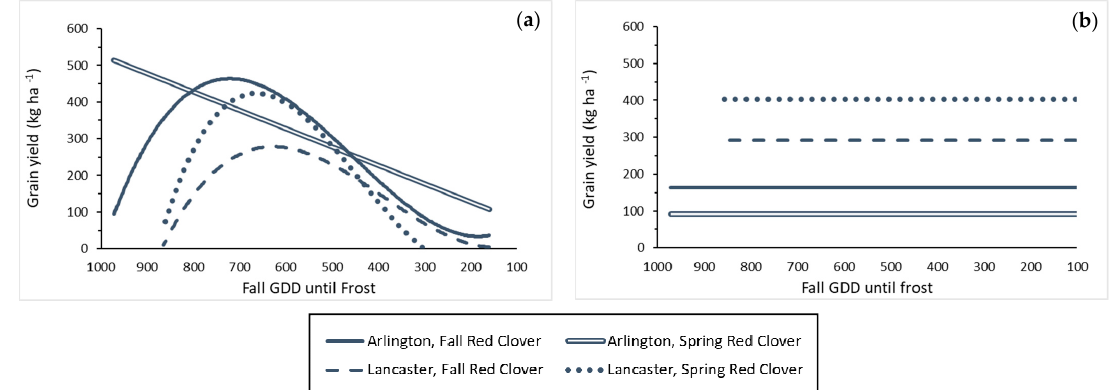
Figure 3. Lines of estimated values from best fit models of Kernza grain yield in kg ha − 1 for Arlington and Lancaster’s fall and spring planted red clover treatments in ( a ) the first harvest year and ( b ) the second harvest year. Y axis: Kernza grain yield; x axis: planting date represented by fall growing degree days until frost (earlier planting dates correspond to higher x values). The first year line equations and p -values are: Arlington, fall red clover: Y = − 0.000006x 3 + 0.01x 2 − 2.2x + 220.6 ( p = 0.01); Arlington, spring red clover: Y = 0.5x + 27.8 ( p = 0.01); Lancaster, fall red clover: Y = − 0.000005x 3 + 0.01x 2 − 1.4x + 99.9 ( p = 0.02); Lancaster, spring red clover: Y = − 0.00001x 3 + 0.01x 2 − 4.5x + 390.1 ( p < 0.05).